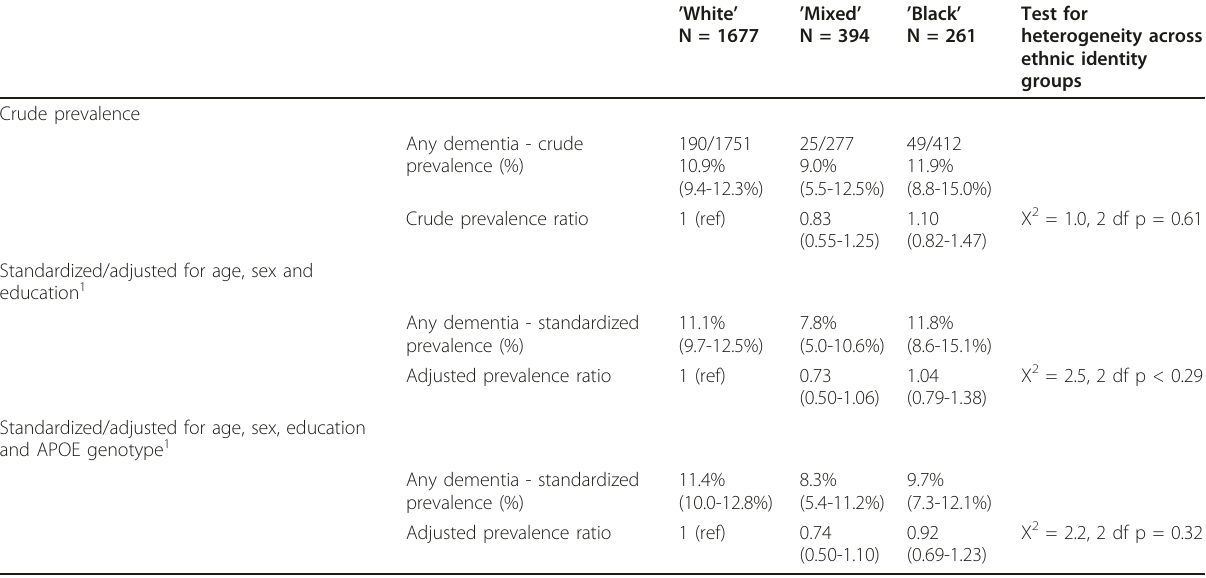
Table 4 Crude and adjusted dementia prevalence by ethnic identity, with prevalence ratios